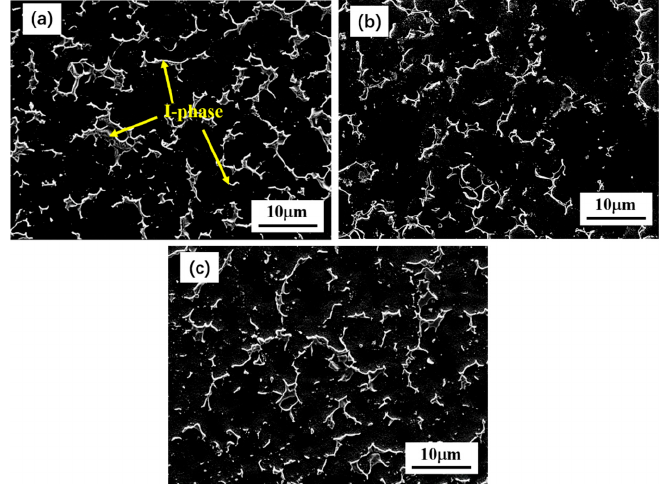
Figure 7. Scanning electron microscopy (SEM) micrographs in the as-cast Mg-Zn-4Al- x Sn alloys: ( a ) ZA64, ( b ) ZAT641, and ( c ) ZAT642.